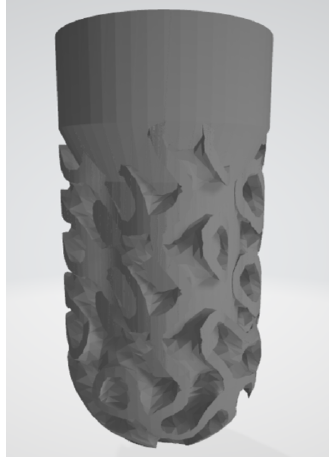
Figure 3. The second, porous geometrical solution of the dental implant used for numerical simulations. Implant was previously patented in the Czech Repub- lic [7]. Image shows the intraosseous